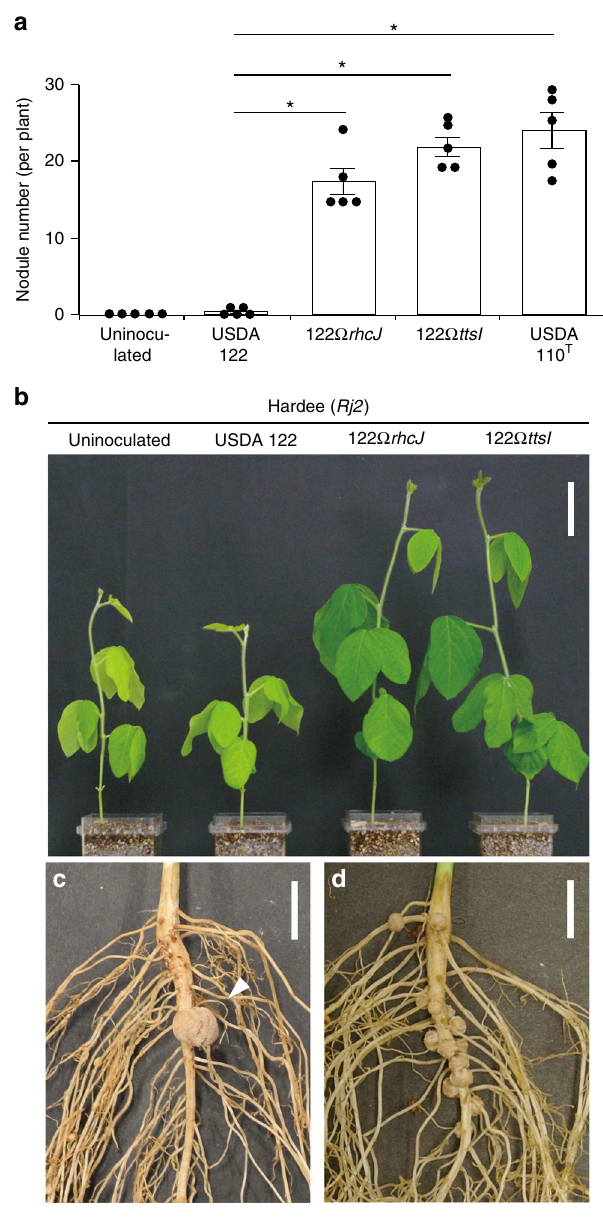
Fig. 1 Symbiotic phenotypes of Hardee ( Rj2 ) inoculated with B. diazoef fi ciens strains. a Number of nodules formed on roots at 28 days after rhizobial inoculation. No experimental repeat was conducted with the same comparison. Error bars show SEM ( n = 5). *Signi fi cant difference from USDA 122 ( P < 0.01 by Dunnett ’ s multiple comparison test). b Shoots 28 days after inoculation with the indicated strains. Scale bar, 5 cm. c Roots of plants inoculated with USDA 122. The arrow indicates a single sporadic nodule; normal nodules were rarely formed by USDA 122. Scale bar, 1